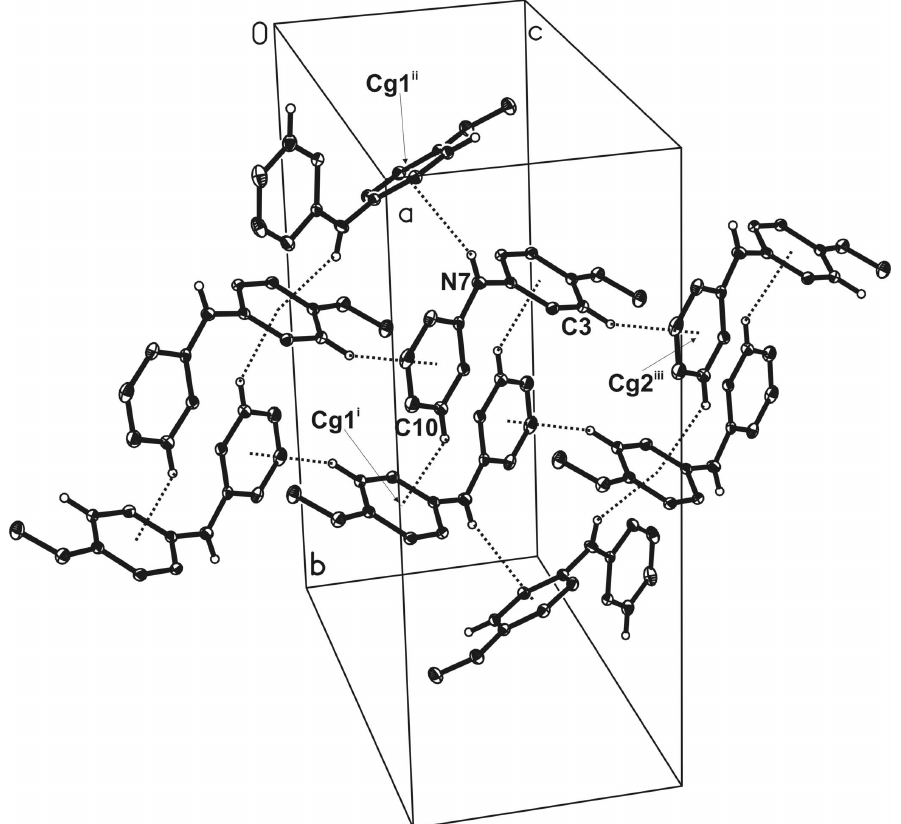
Figure 2 The arrangement of the molecules in the crystal packing, viewed approximately along the a axis. The C—H··· π and N— H··· π interactions are represented by dotted lines. H atoms not involved in interactions have been omitted [symmetry codes: (i) x , y , 1 + z ; (ii) x , 1/2 - y , -1/2 + z ; (iii) 1 - x , 1 - y , 1 - z